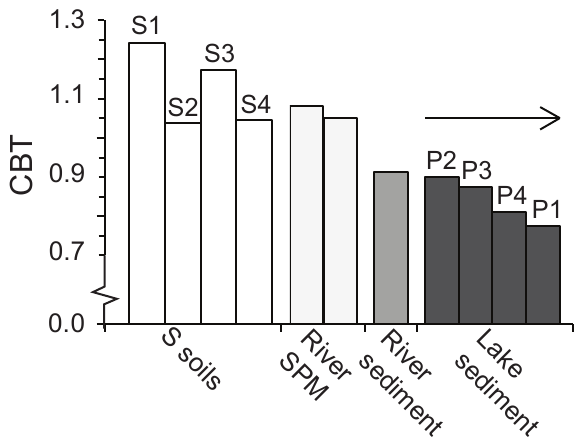
Figure 7. CL CBT ratios of soils from the south catchment area; river SPM and river sediment from Endrick Water (south basin); and lake sediments from the south basin (labelled). The arrow indi- cates the increasing distance from the mouth of Endrick Water and increasing water depth of the lake